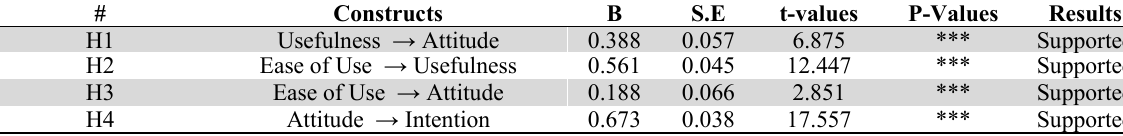
Results of Structural Model Analysis (Hypothesis Testing)